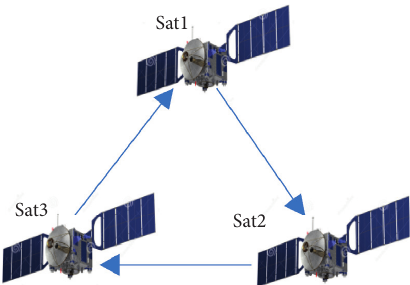
Figure 2: The directed communication topology of three follower spacecraft.